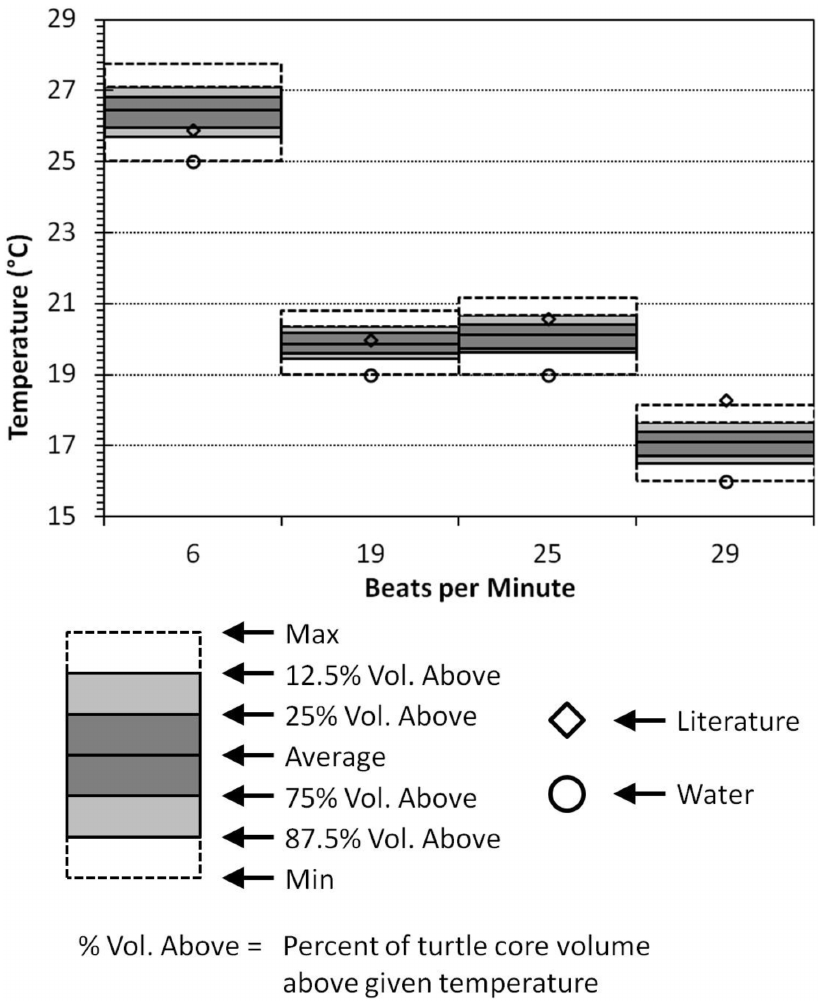
Figure 13. A comparison between the simulated and experimental internal temperatures. The dotted boxes contain the range of temperatures inside the simulated turtle’s core region. The light gray region bounds the 75 th temperature percentile of the turtle’s core volume and the dark gray box bounds the 50th Temperature percentile of the turtle’s core volume. Experimental data from literature [23].